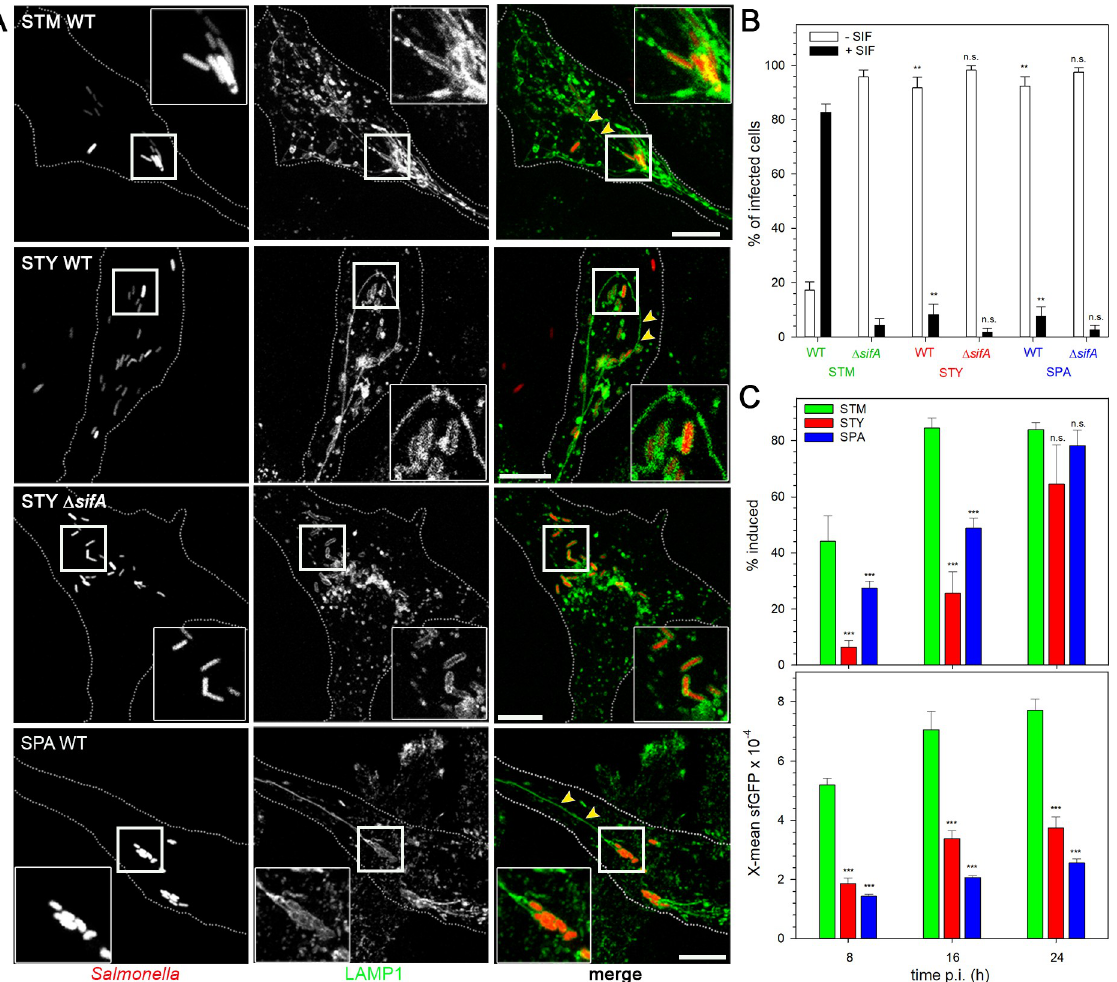
Fig 4. Endosomal remodeling in host cells infected with STM, SPA, or STY is dependent on function of SifA. A ) HeLa LAMP1-GFP cells were infected with WT or Δ sifA strains of STM, STY or SPA as indicated, constitutively expression mCherry (red) at MOI 50. Cells were fixed at 8 h p.i. and microscopy was performed by CLSM on a Leica SP5 using a 100x objective. Representative infected host cells are shown. Boxes indicate areas containing SCV that are magnified in insets. Yellow arrowheads indicate Salmonella -induced filaments (SIF). Scale bar: 10 μ m. B ) Quantification of SIF formation in HeLa cell infected by STM, STY, or SPA. HeLa LAMP1-GFP cells were infected with WT or sifA mutant strains of STM, STY, or SPA at MOI 50. Cells were fixed 8 h p.i., and microscopy was performed using a cell observer widefield system (Zeiss) with a 100x objective. At least 100 cells per strain were counted, and infected cells were scored for appearance of SIF (black bars) or absence of SIF (open bars). C) Induction of sifA expression by intracellular Salmonella . HeLa cells were infected with STM (green), STY (red), or SPA (blue) WT, each harboring dual fluorescence reporter p5633 for constitutive expression of DsRed, and P -controlled expression of sifA sfGFP. Host cells were lysed 8, 16, or 24 h p.i. as indicated, and released bacteria were subjected to FC analyses as described for Fig 1. The proportion of intracellular Salmonella positive for P induction is expressed as percentage of the entire population. The X-mean sfGFP sifA fluorescence of the induced subpopulation was quantified. In B ) and C ) means and standard deviations of three biological replicates are shown. Statistical analysis was performed by One-way ANOVA and are indicated as follows: n.s., not significant; � , P < 0.05; �� , P < 0.01; ��� , P < 0.001. presence of late endosomal/lysosomal membrane markers. We investigated the formation of SIF in SPA- or STY-infected host cells. Endosomal remodeling depends on function of the SPI2-T3SS, and effector protein SifA is essential for SIF formation and integrity of the SCV [23,24]. Infected cells were analyzed for formation of SIF and we compared intracellular phe- notypes of WT and Δ sifA strains of the various serovars. In infected HeLa or RAW cells, we observed formation of LAMP1-GFP-positive membrane compartments that completely